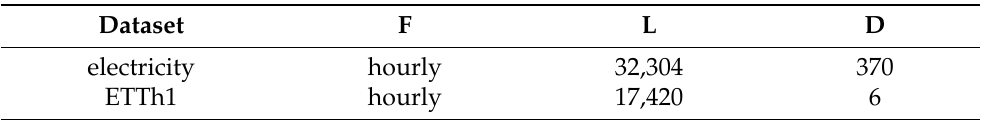
Table 1. Dataset data, where F represents the sampling frequency, L represents the number of samples, and D represents the data dimension.